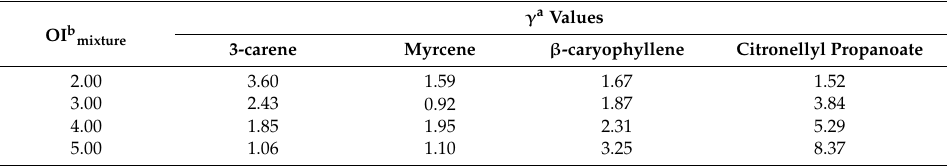
Table 4. Example of γ values for four key